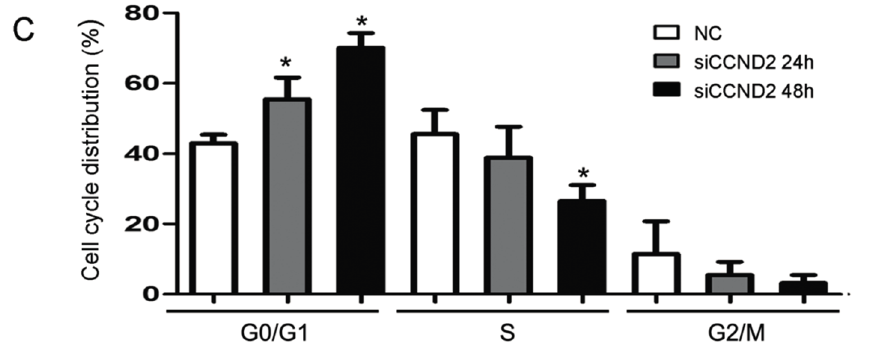
Figure 4. CCND2 siRNA transfection inhibited HaCaT cell proliferation by blocking cell cycle at G1 phase. ( A ) CCND2 siRNA transfection led to a significant reduction of mRNA expression of CCND2 in HaCaT cells both at 24 h (73.79% ± 11.45%) and 48 h (51.18% ± 8.85%); ( B ) Cell viability analysis showed that CCND2 siRNA transfection inhibited HaCaT cell proliferation at 24 h (67.98% ± 7.31%) and 48 h (67.45% ± 6.70%); ( C ) FCM analysis showed the effect of CCND2 siRNA transfection on cell cycle progression, and G1 phase arrest was obvious at 24 h (55.51% ± 6.18%) and 48 h (70.19% ± 4.10%) compared with negative control (42.98% ± 2.48%). (NC, negative control. * Compared with NC, p <